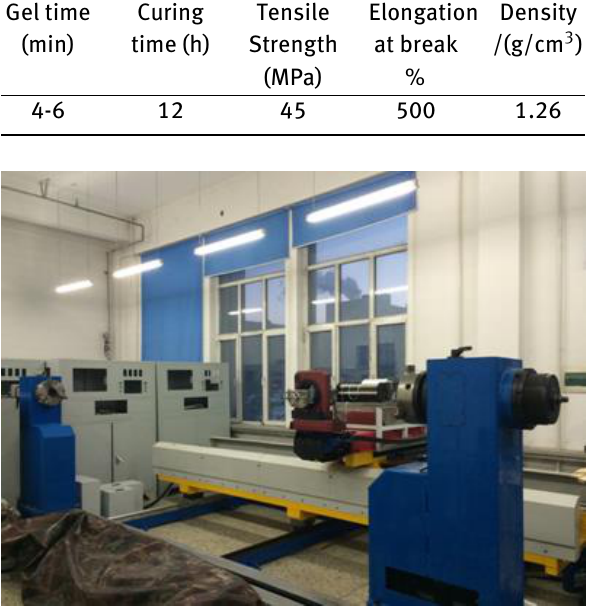
Figure 1: Gasbag winding experimental